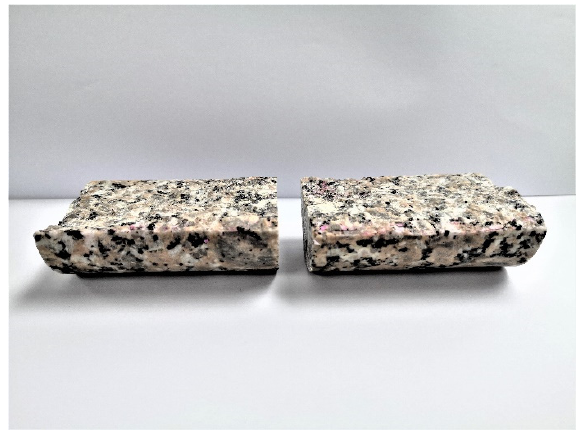
Figure 2. Photographs of fractured sample. Through three-dimensional scanning of these fracture surfaces, a large number of point sets of three-dimensional coordinates can be obtained. Based on these point sets, a visual image of the fracture surface can be obtained (Figure 3), and the joint roughness coefficient (JRC) of the fracture surface can be calculated according to the following formulas [59,60]: